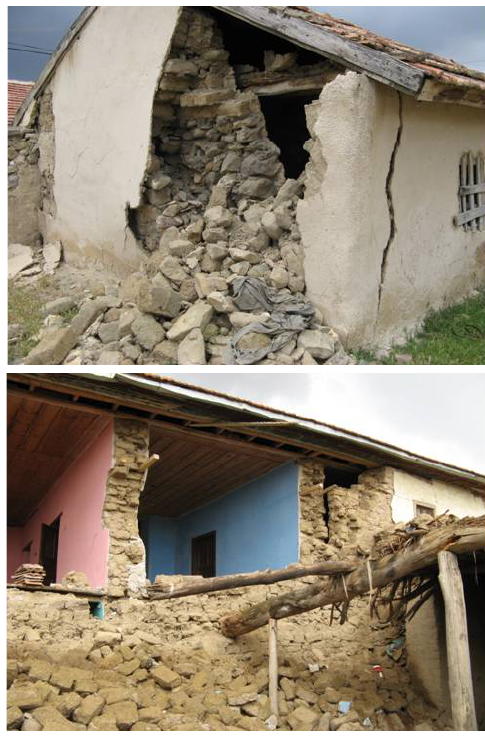
Fig. 9. Examples of heavily damaged masonry buildings. Fig. 9 Examples of heavily damaged masonry buildings